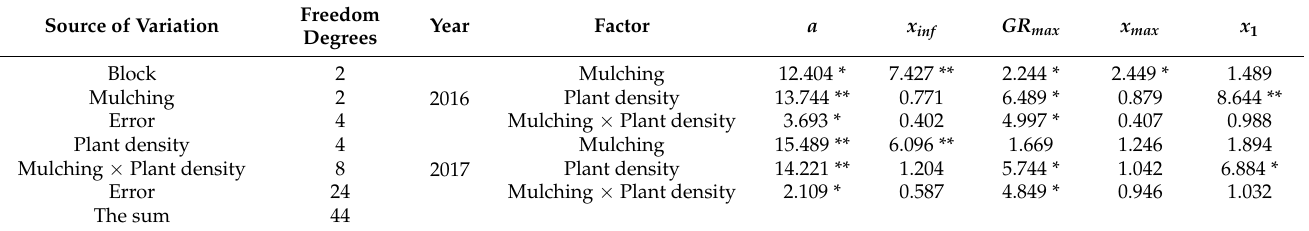
Table 6. Variance analysis of dynamic characteristic parameters of dry matter accumulation under different treatments. The data in the table are F values. * indicates significantly different at p < 0.05 level. ** indicates significantly different at p < 0.01